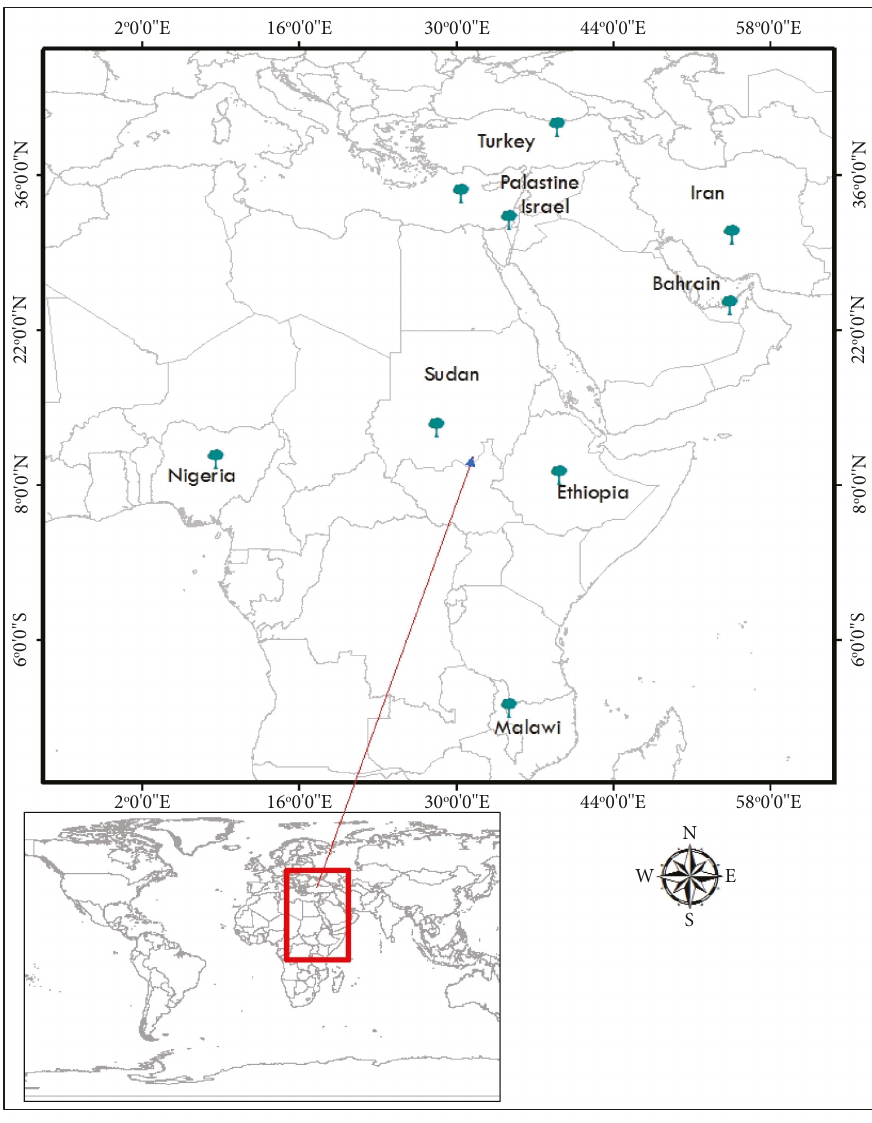
Figure 2: Distribution of Ziziphus spina